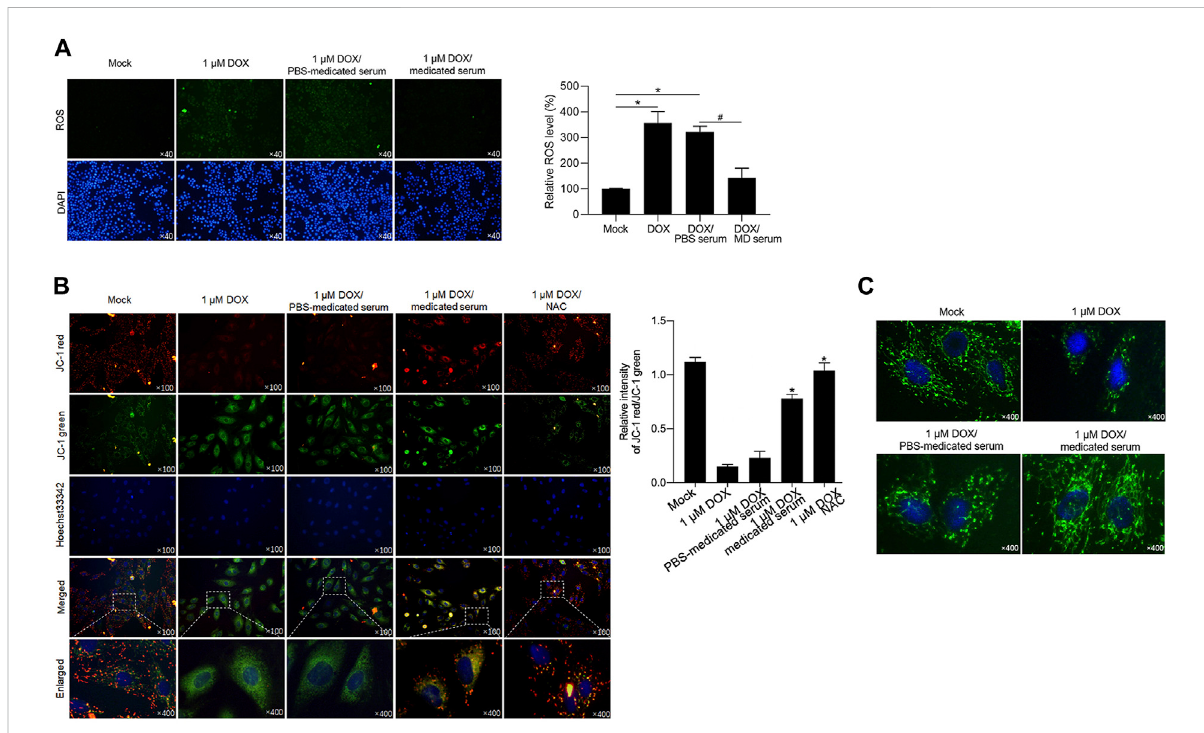
FIGURE 6 YXX keli decreased ROS accumulation induced by DOX in RCM. (A) . After DOX treatment, ROS accumulation was detected. * p < 0.05, vs. mock group; # p < 0.05, vs. DOX/PBS-medicated serum. (B) . Mitochondrial membrane potential was measured by performing JC-1 staining. (C) . Mitotracker staining was performed to detect